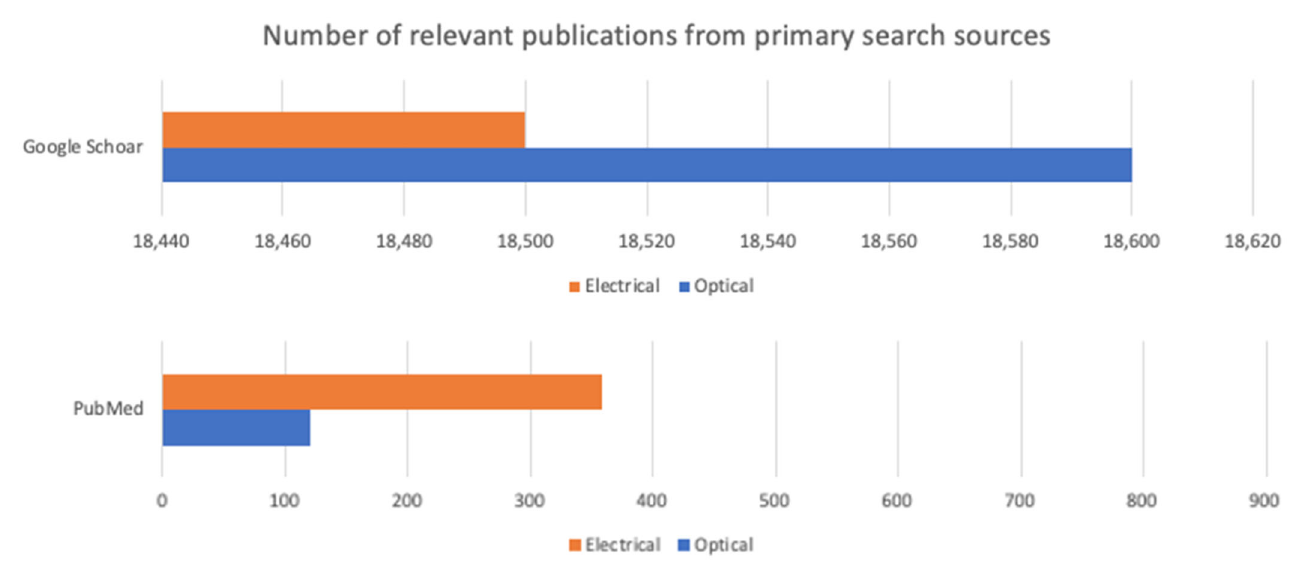
Figure 2. Top : PRISMA flow diagram of yielded database searches. Bottom : Bar charts to show split of relevant publications appearing from 2 primary search sources.